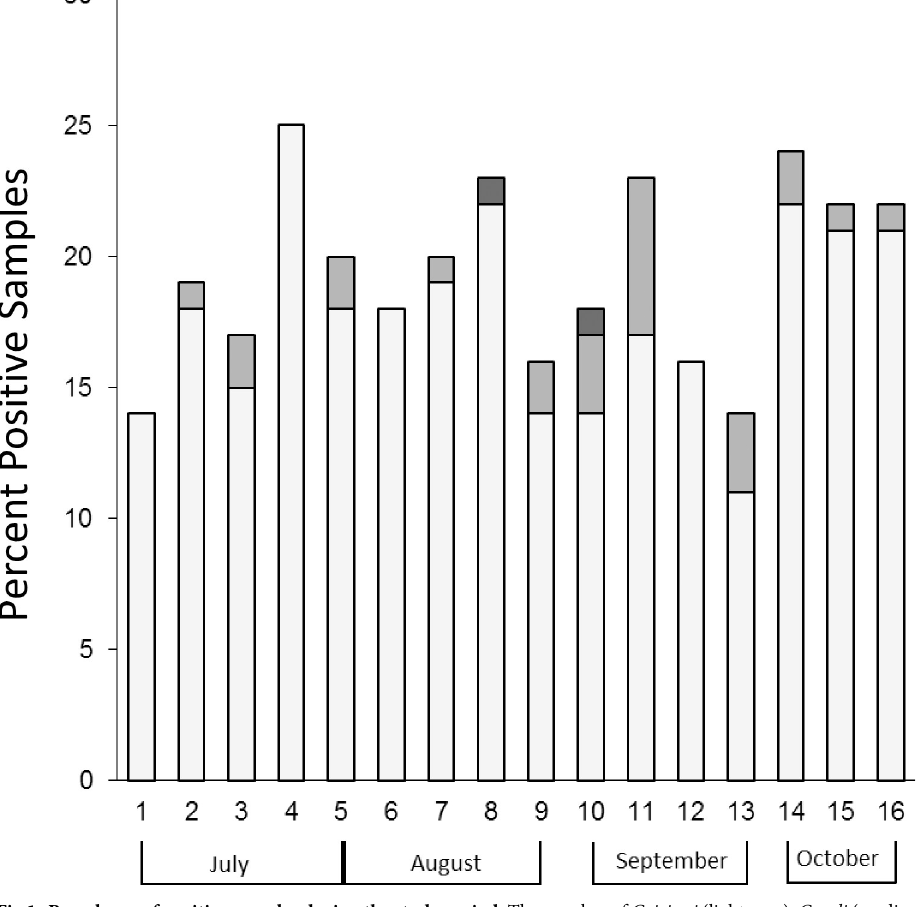
PLOS ONE | https://doi.org/10.1371/journal.pone.0215928 May 8,